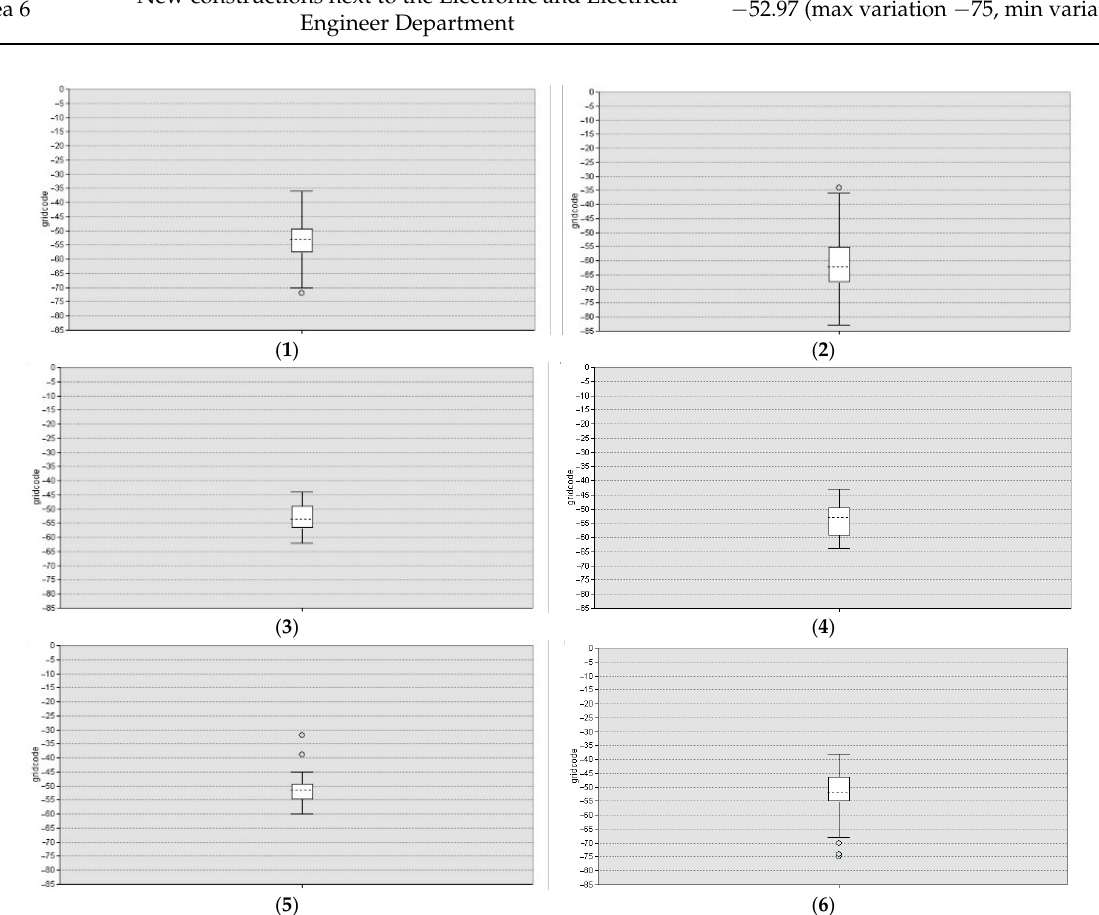
Figure 11. New construction next to the Electronics and Electrical Engineering Department.